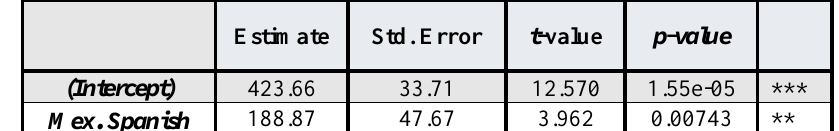
Table 3. Regression coefficients for the fixed linear effects model predicting vowel dispersion. The Intercept coefficient is vowel dispersion in Bay Area Spanish and the estimates are measures in